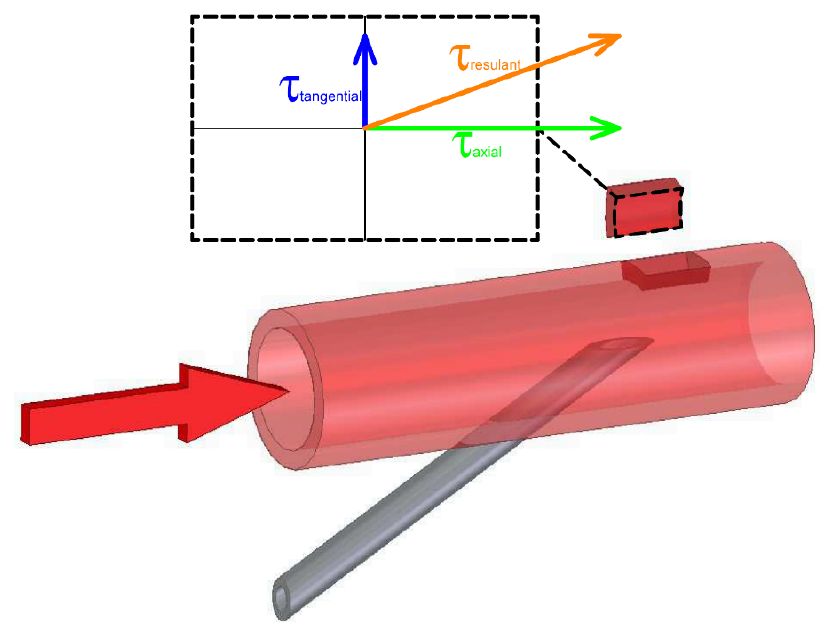
Figure 1. Schematic of the distribution of WSS components on the vessel wall. WSS has two components. These are tangential and axial components. The tangential component acts tangentially on the circumference of the vascular wall. The axial component of the WSS always acts in the direction of blood flow. The axial component of the WSS can therefore be used as an indicator of the direction of flow. If the value of the axial component becomes negative, then there is a backflow of blood.